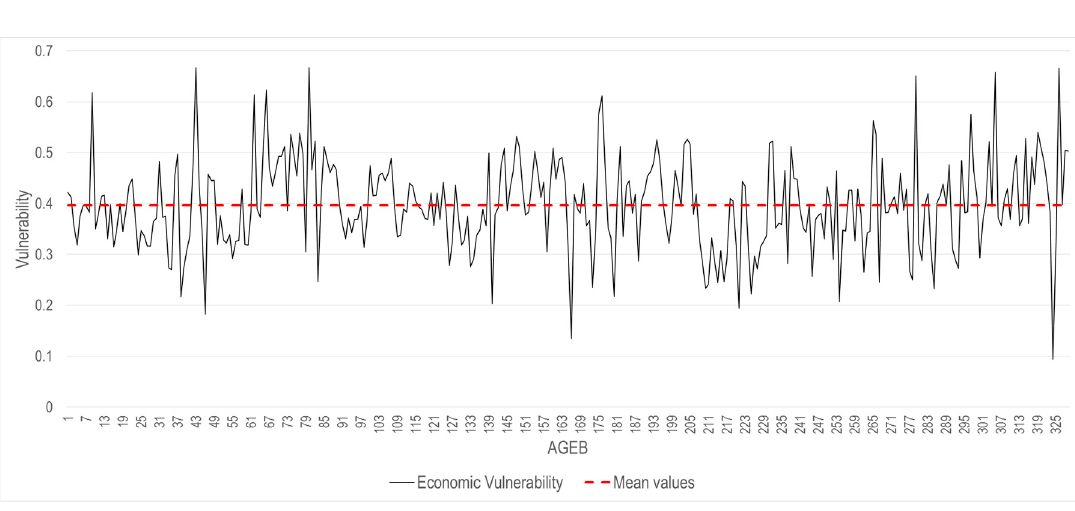
Figure 4. Spatial distribution of the AGEBS with a social vulnerability above the average value.